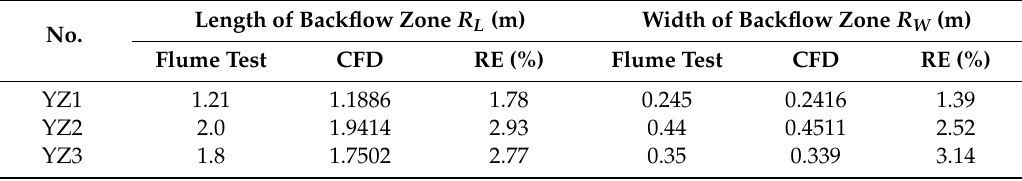
Table 4. Comparison of R L and R W between observed and computed (spur dike